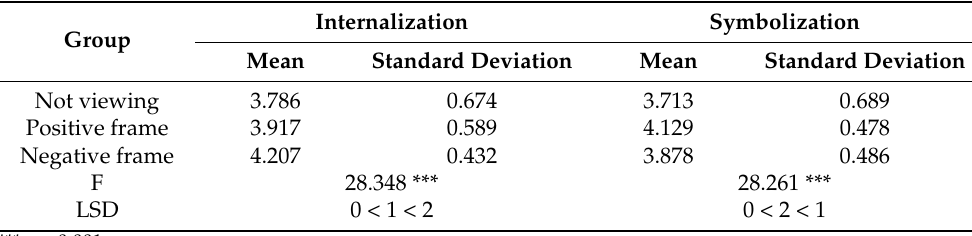
Table 4. ANOVA of moral identity under different message